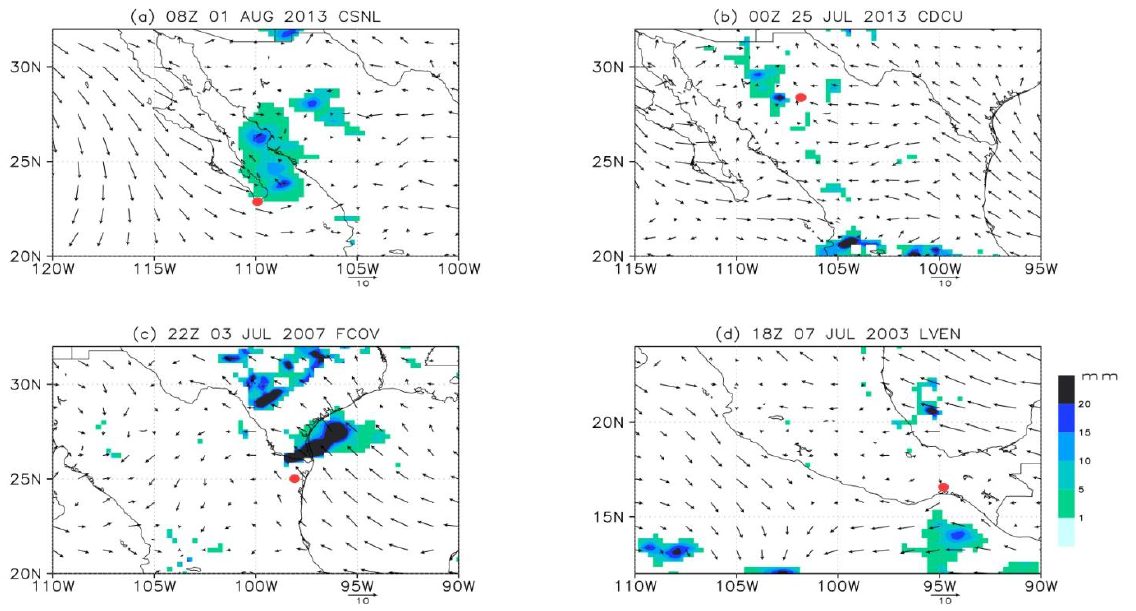
Figure 5. Summer ramp-up events at ( a ) CSNL, ( b ) CDCU, ( c ) FCOV and ( d ) LVEN. Weather station location is indicated with a red circle. 3 h average ERA5 [42] surface wind speed and CMORPH [43] accumulated precipitation in mm (shaded) centered around the wind-ramp occurrence (weather station).